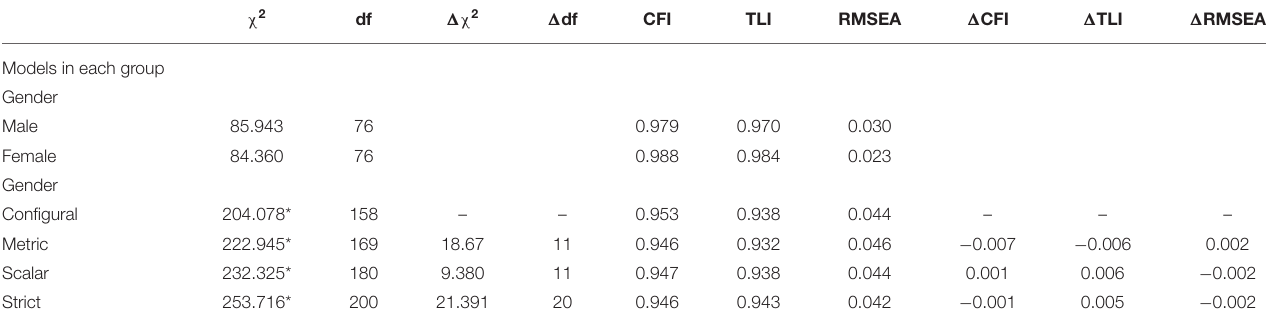
TABLE 4 | Tested models and goodness-of-fit indices.